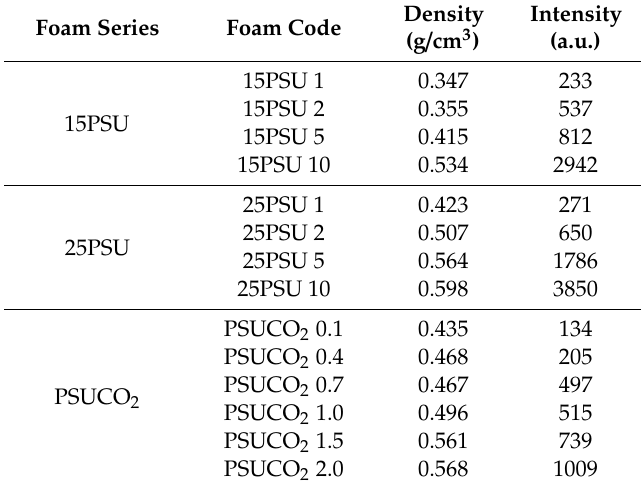
Table 1. Density and intensity of the characteristic (002) di ff raction peak of graphene for all the microcellular nanocomposites. Foam Series Foam Code